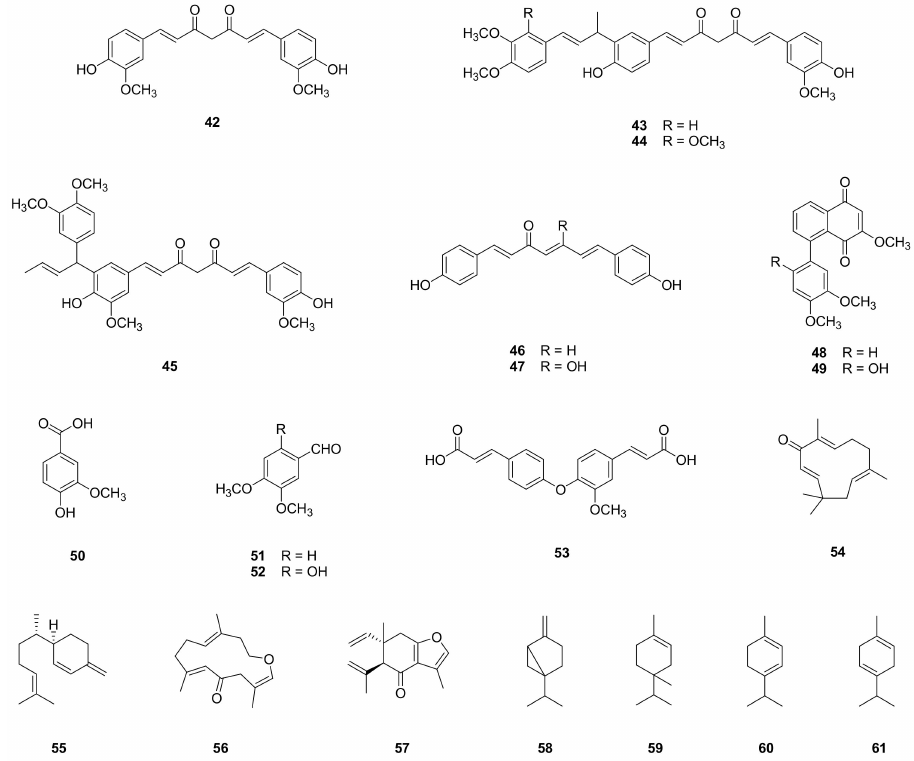
Figure 3. Structures of other compounds isolated from Z. cassumunar . Curcuminoids, 42 – 47 ; quinones, 48 and 49 ; phenolic compounds, 50 – 53 ; sesquiterpenoids, 54 – 57 ; and monoterpenoids, 58 – 61